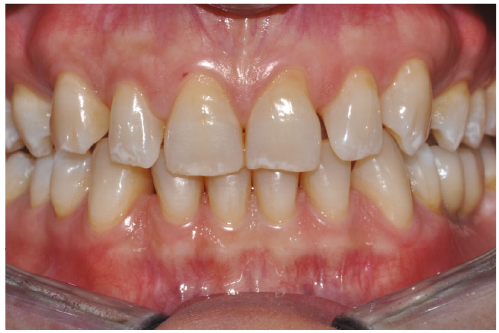
Figure 1: Initial intraoral situation.